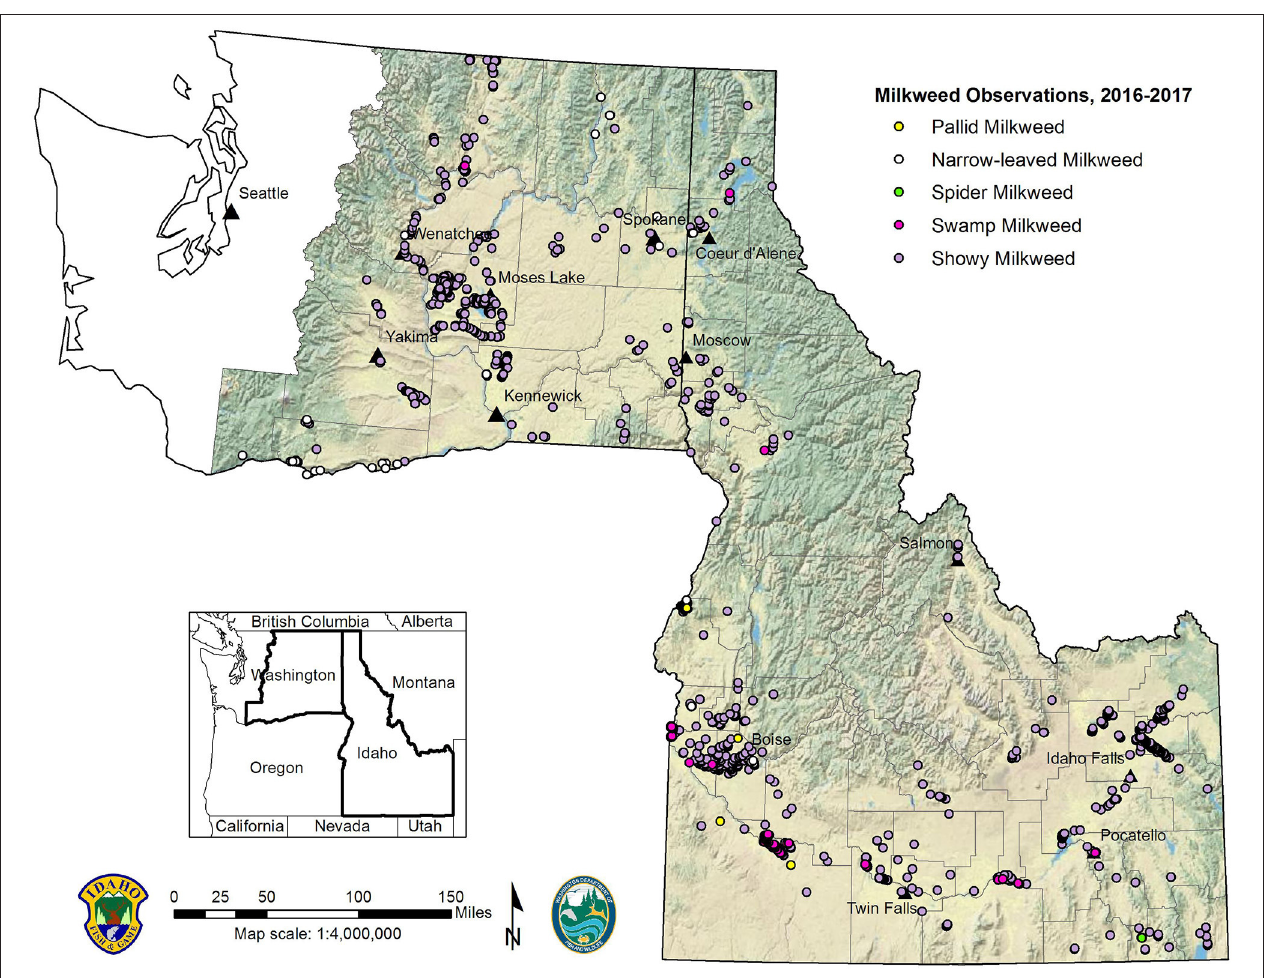
FIGURE 1 | Distribution of milkweed observations in Idaho and Washington,